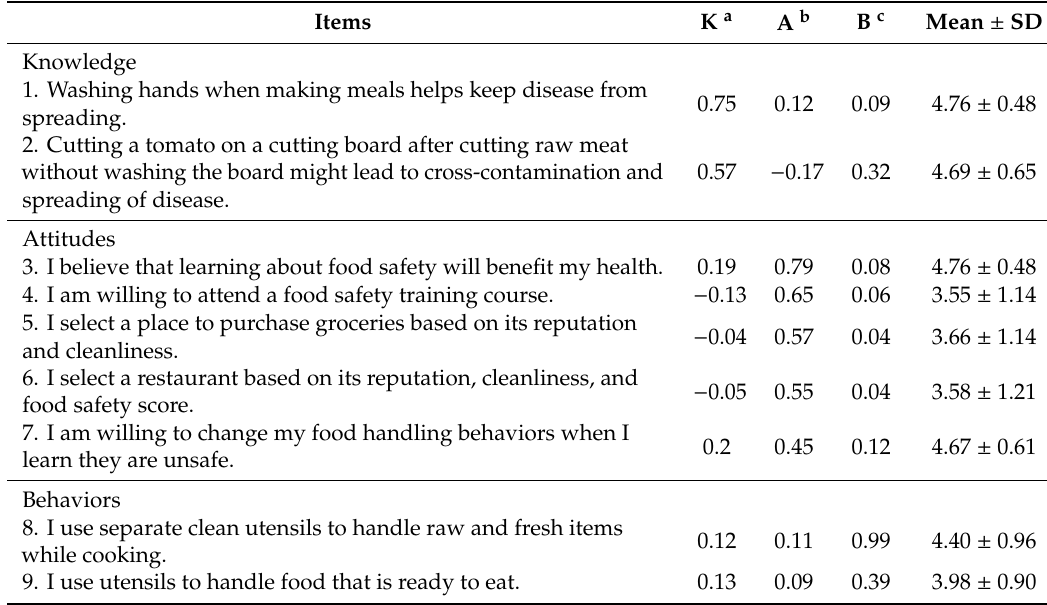
Table 5. Exploratory factor analysis results for the Food scale.